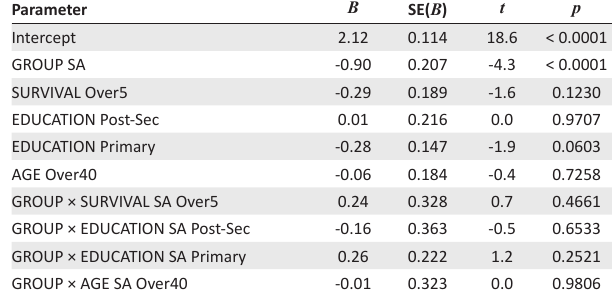
TABLE 5: Parameter estimates for two-way interaction analysis of variance model of use of print media.